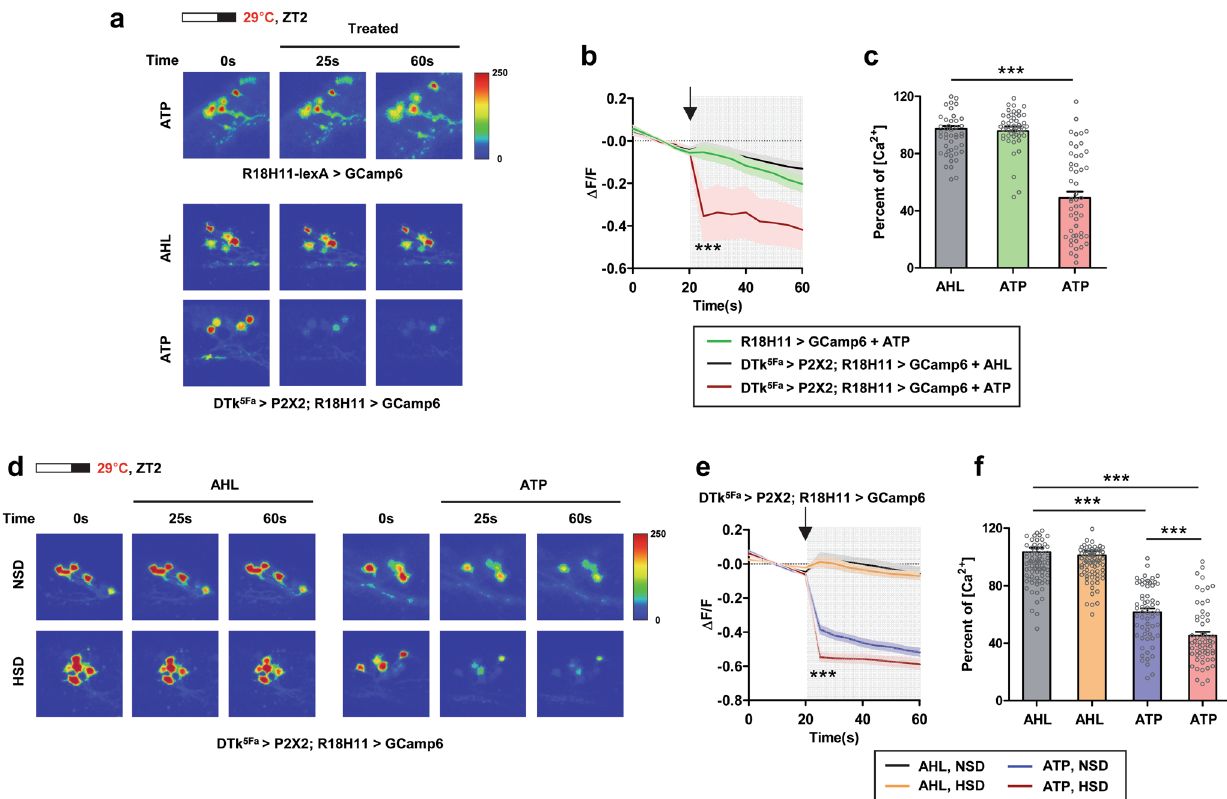
Fig. 6 DTk neuron reduced intracellular Ca 2 + levels in DN1 p s. a – f Flies of the indicated genotypes were maintained on a 16L:8D cycle at 29 °C. On day 7, brains were dissected at ZT2 ~ 4. a , d Images with GCaMP-positive DN1 p s following application of AHL or ATP. b , e Δ F/F values over time following AHL or ATP application (arrow) are shown. c , f Relative fold changes of intracellular Ca 2 + levels. c Δ F/F values were normalized to AHL applied DTk 5Fa > P2X2; R18H11 > GCamp6 fl ies at 25 s. Bars indicate mean ± SEM ( n = 45 – 51). Statistically signi fi cant differences between AHL and ATP treated groups (independent t test): *** P < 0.001. f Δ F/F values were normalized to AHL applied DTk 5Fa > P2X2; R18H11 > GCamp6 fl ies fed with a NSD at 25 s. Bars indicate mean ± SEM ( n = 61 – 89). Statistically signi fi cant differences between AHL and ATP treated groups or between NSD and HSD condition (independent t test): *** P <